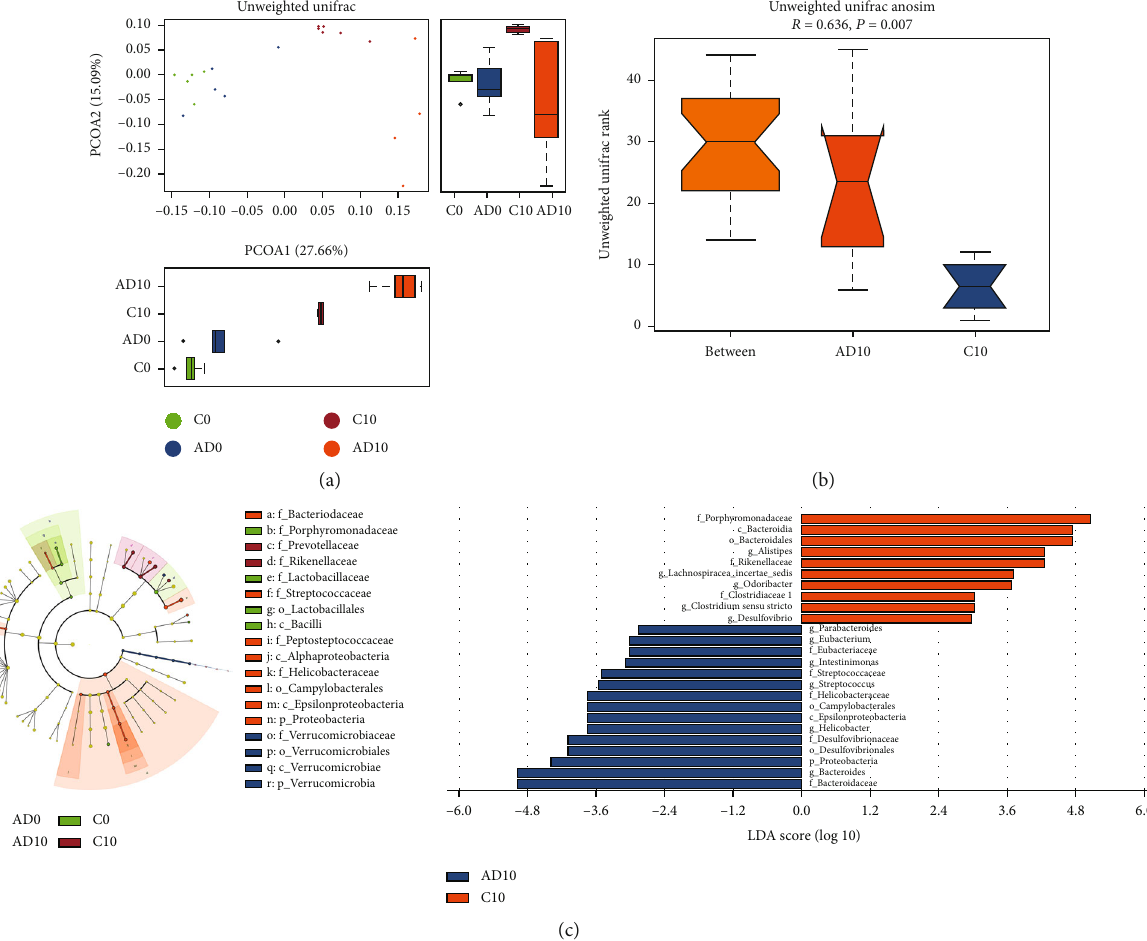
Figure 4: The alteration of gut microbiota during colitis-associated cancer development. (a) The PCoA plot showed a signi fi cant distinction in microbial composition among the two groups at 10 weeks. (b) Unweighted Unifrac Anosim analysis suggested a reasonable grouping after AOM/DSS treatment. (c) The LefSe analysis listed bacteria with signi fi cant di ff erences at di ff erent levels in each group. C0 and C10: control group at 0 and 10 weeks. AD0 and AD10: AOM/DSS group at 0 and 10 weeks. n = 5 in each